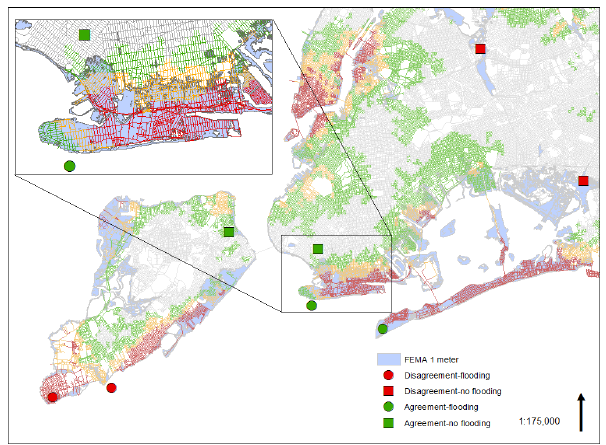
Fig. 11. Locations of photos which illustrate agreement and dis- agreement between FEMA and the crowdsourced data.